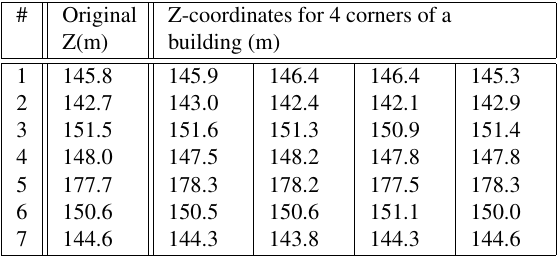
Table 2: Comparison of Z-coordinate results with correlation step for set of buildings (Figure 5)